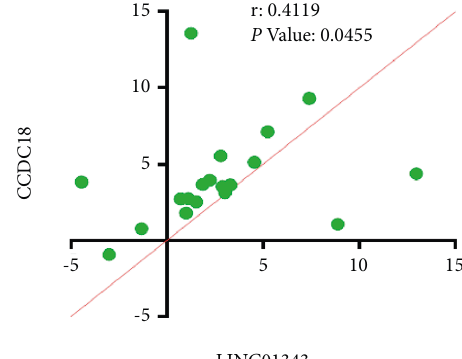
Figure 6: According to the spearman correlation analysis, there was a significant positive correlation between the expression level of CCDC18-AS1 and LINC01343 in BC